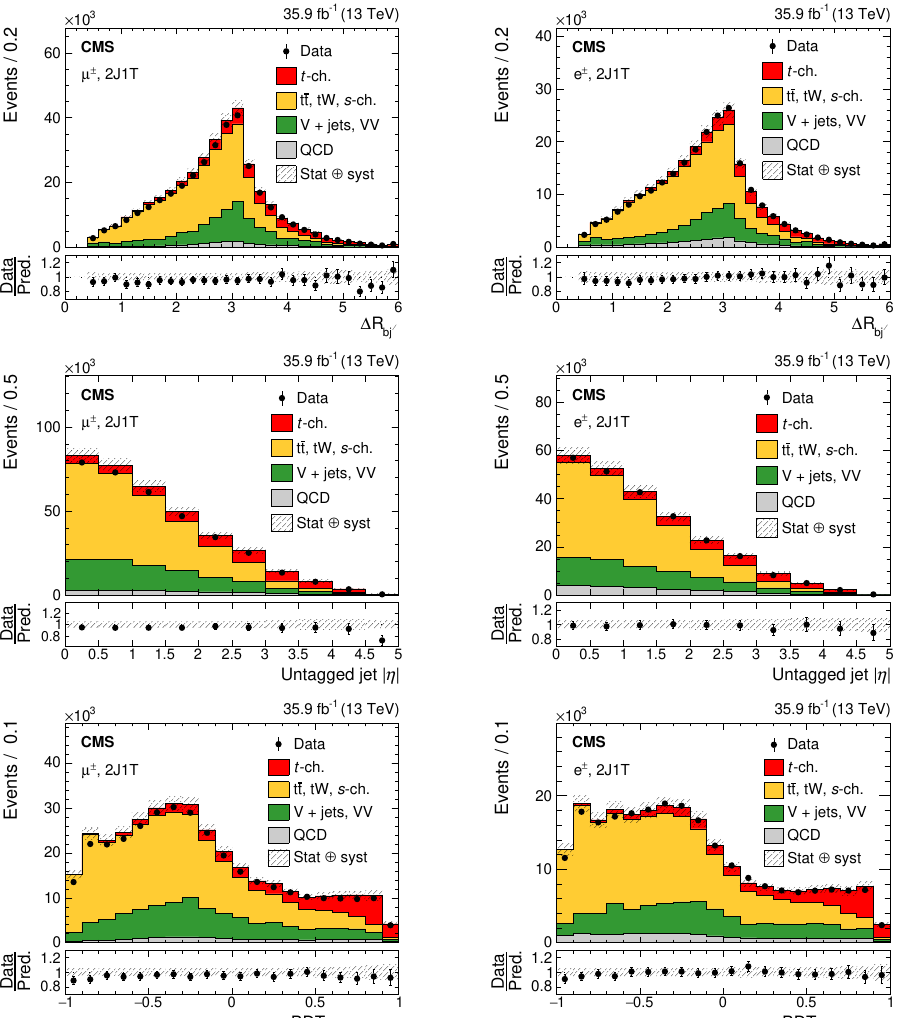
(upper row), untagged jet | η | (middle row), Figure 4 . Data and simulation comparison for ∆ R bj 0 and BDT response (lower row) in the 2J1T category for the muon (left) and electron (right) final states. The lower panels show the ratio of the data to simulation predictions. The bands indicate the statistical and systematic uncertainties added in quadrature. The last bin in each of the upper- row plots includes the